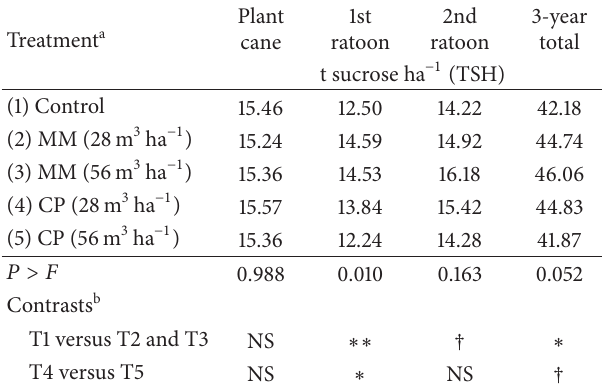
Table 5: Predicted least squares means and 𝑃 > 𝐹 for t sucrose ha −1 (TSH) for individual crop years and cumulative 3-year total at Site 2. Also included are significant